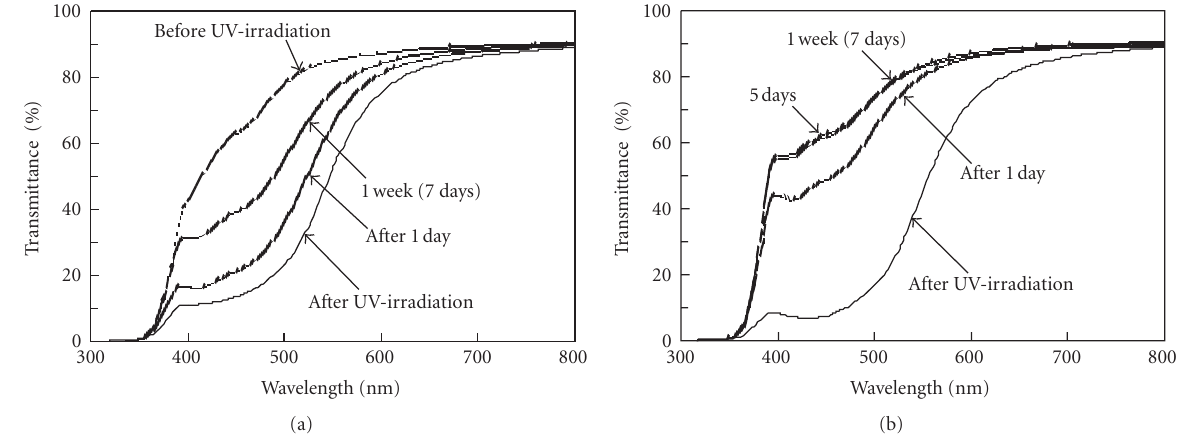
Figure 3: Photochromic property of the (a) heat-treated (Sample 2) film and the (b) as-prepared (Sample 3) film.